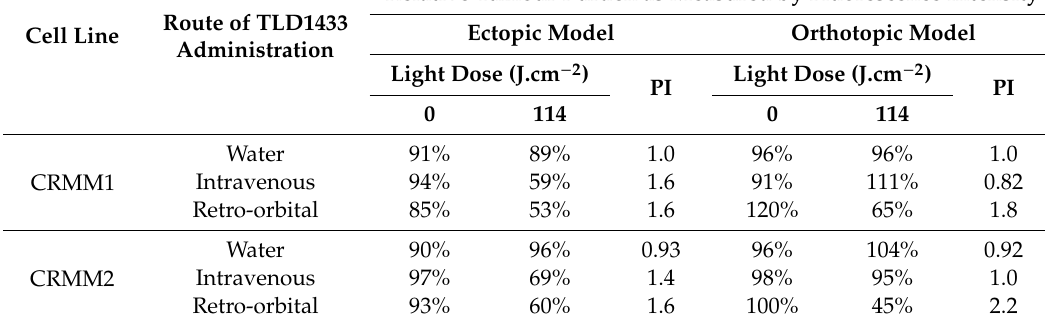
Table 2. The maximum tolerated dose (MTD) of TLD1433 in wild type zebrafish embryos and in the ectopic and orthotopic CM tumour model.